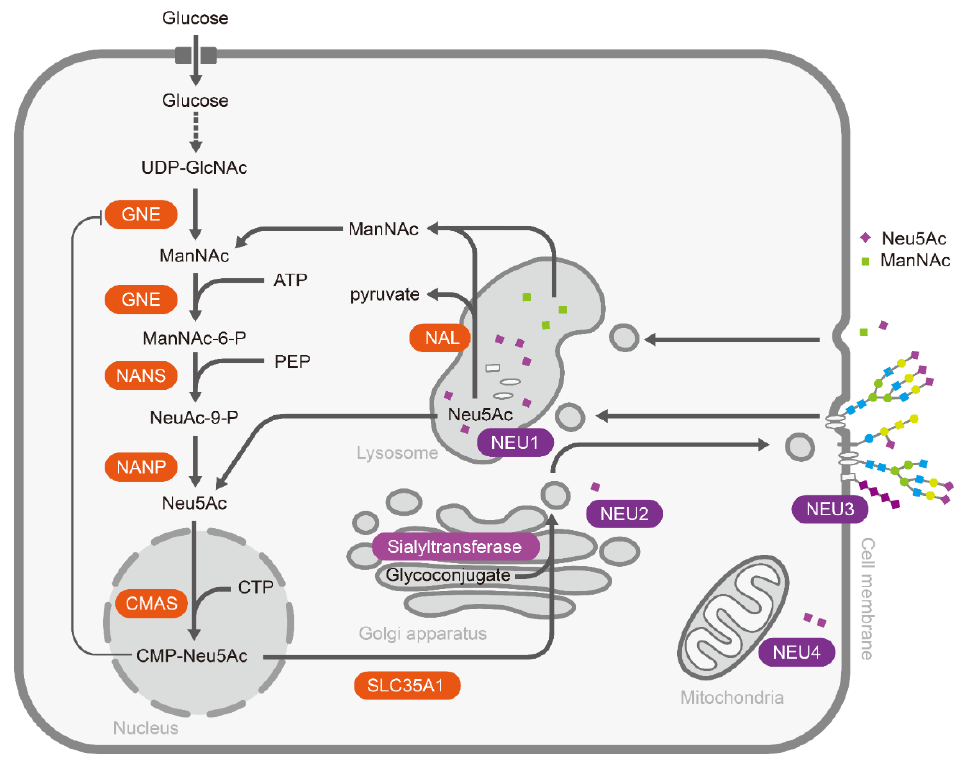
Figure 1. The metabolic pathway of sialic acids in mammalian cells.